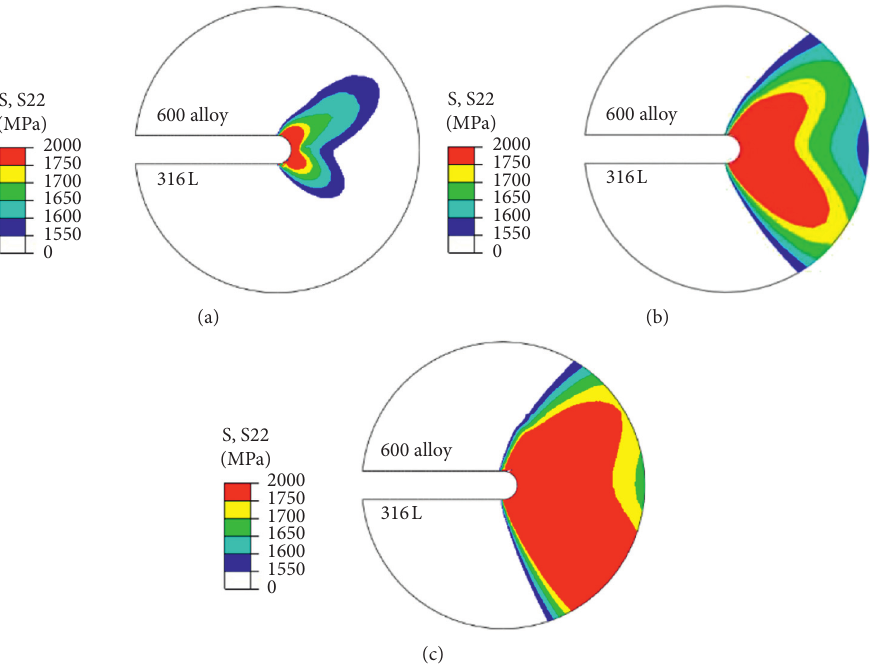
Figure 4: Effect of cold working on tensile stress. (a) CW 0. (b) CW 10. (c) CW